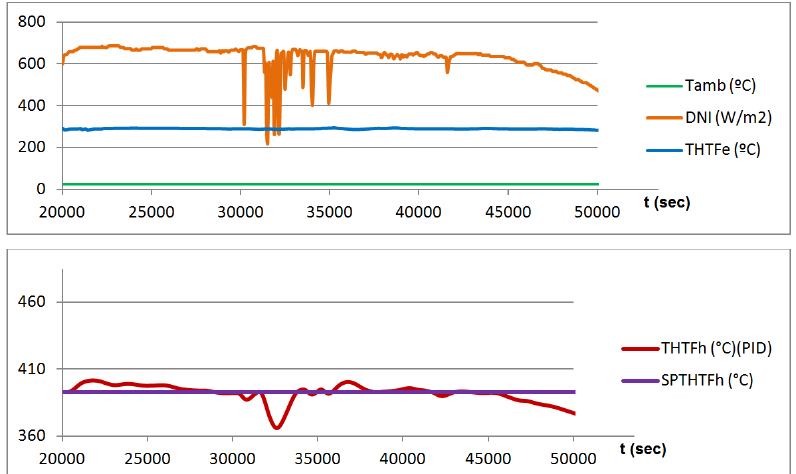
Figure 20. PID controller response to April 2011 values. Energies 2015 , 8, page–page